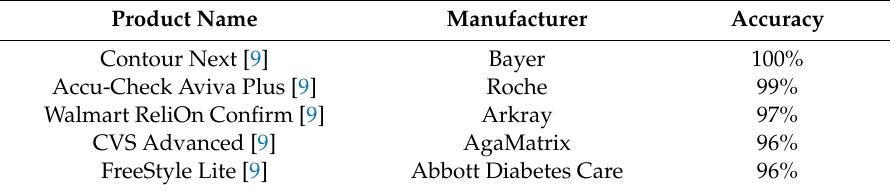
Table 2. FDA approved invasive blood glucose monitors with accuracies.